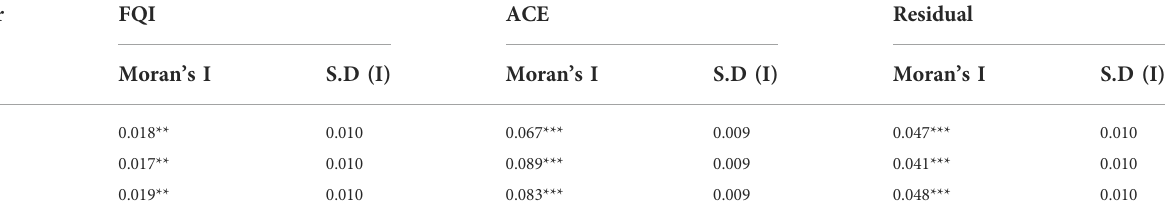
TABLE 4 Spatial correlation